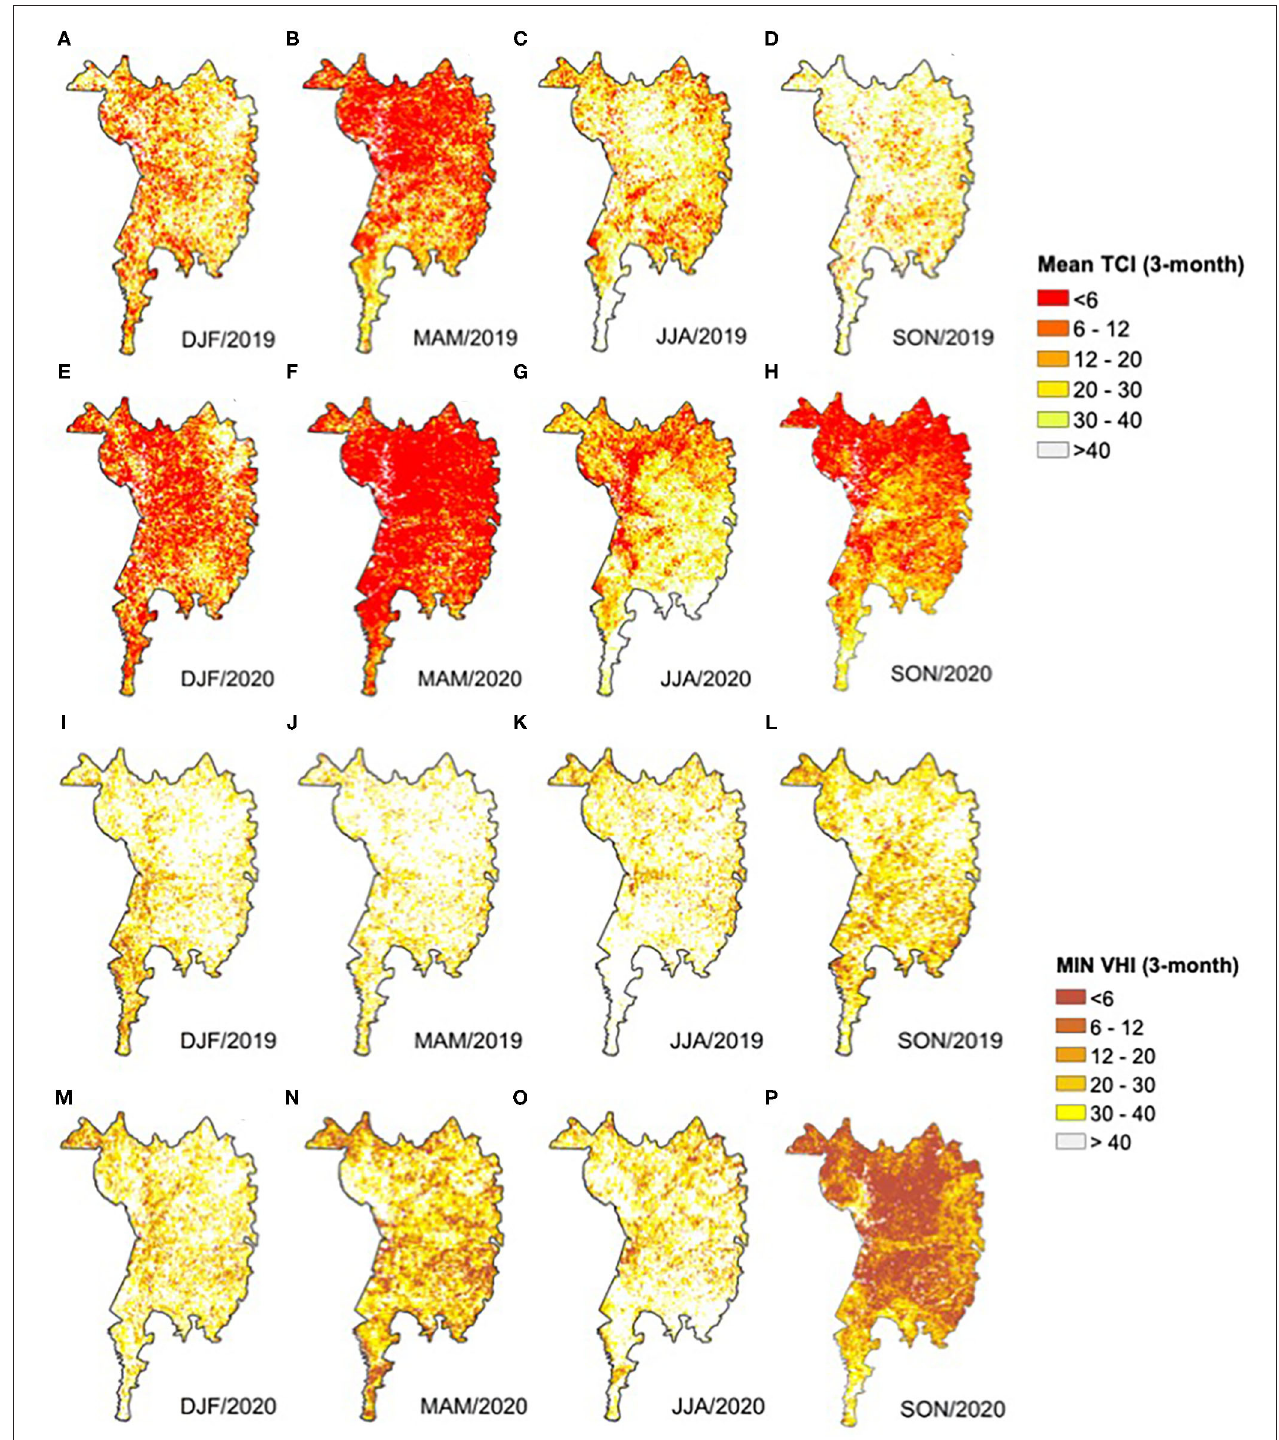
FIGURE 8 | (A–H) seasonal TCI-3-month values for the Brazilian Pantanal from December-February 2019 to September-November 2020; (I–P) seasonal minimum VHI-3 month for the Brazilian Pantanal from December-February 2019 to September-November 2020 in mm. Base period is 1981–2010. rainfall deficit reduce soil moisture, leading to easy ignition areas, especially from December to December ( Figures 4A,B , 7E–H ). Previous studies have shown that severe drought events and wildfires spread (Littell et al., 2016; Bugalho et al., have a significant impact on wildfire risk. Heat stress and